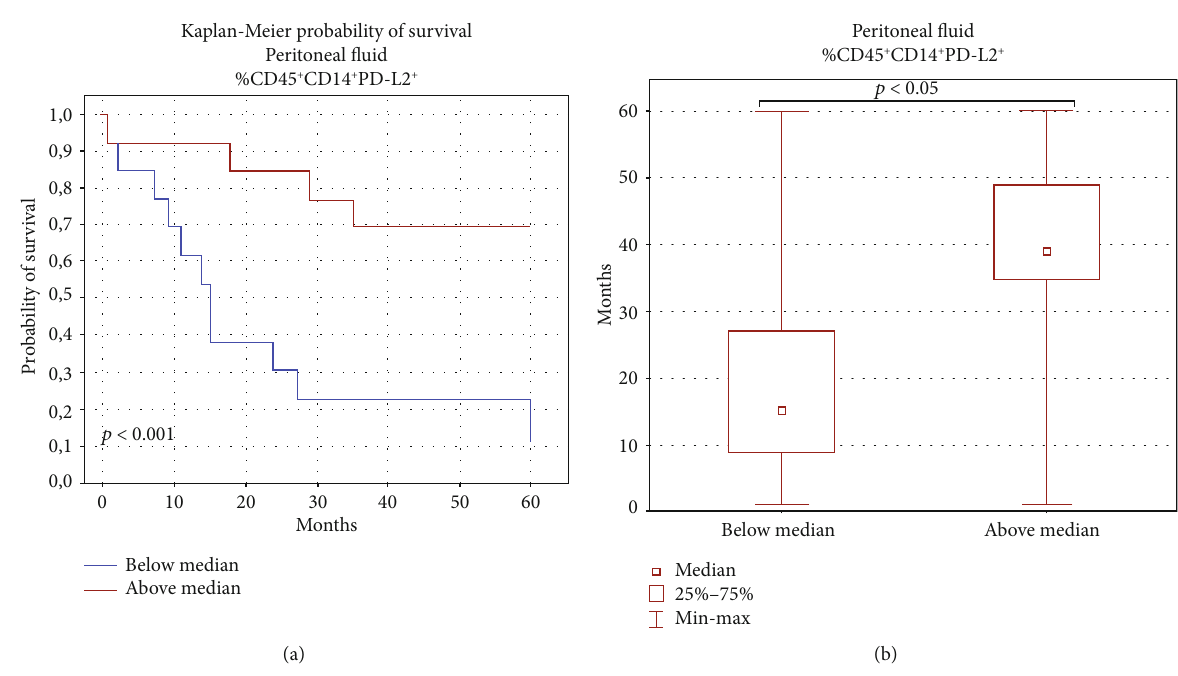
Figure 9: Relationship between CD45 + CD14 + cells with PD-L2 expression in the PF and 5-year survival of OC